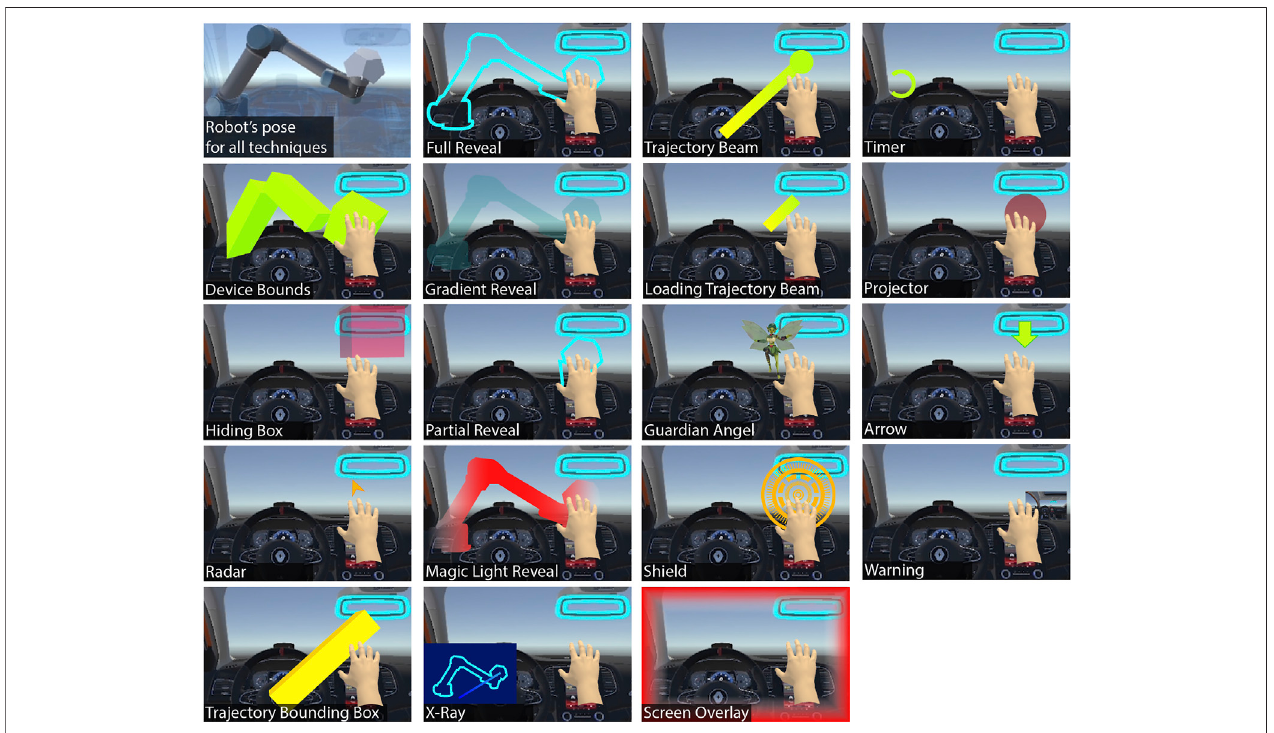
FIGURE7| Illustrationoftheconceived18safety techniques designed. Thesafety techniquesarerepresentedin avirtualenvironmentrepresentinganautomobile interior. All the technique screenshots represent a status with a robot pose as similar as possible to the robot pose shown on the top left.